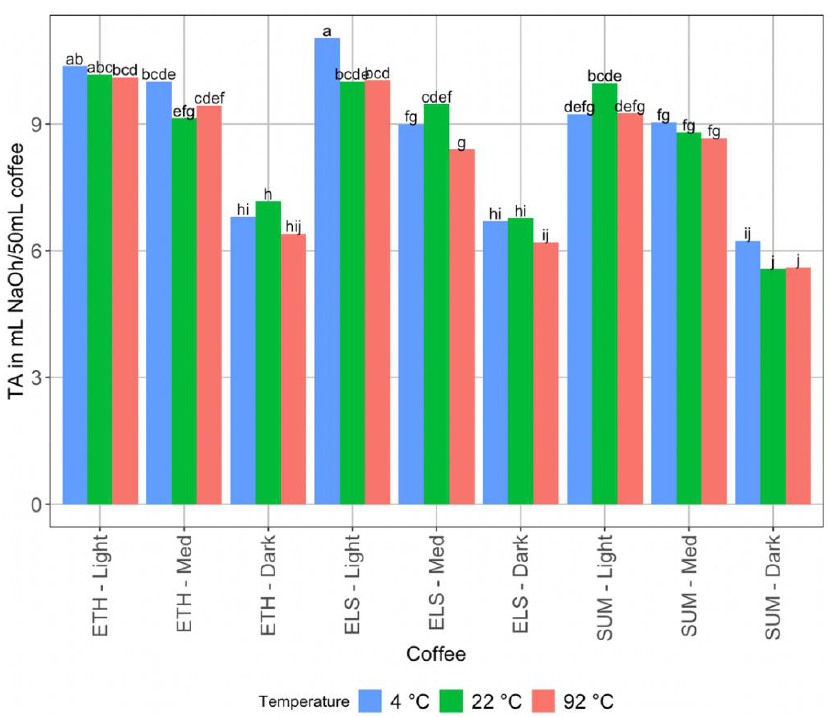
Figure 2. The mean pH value of all brews, with LSD letter codes to indicate significant difference. Codes refer to origin (Eth, ELS, and SUM as Ethiopia, El Salvador, and Sumatra respectively), roast (L, M, or D as light, medium, or dark respectively), and brew temperature (4 °C, 22 °C, and 92 °C).